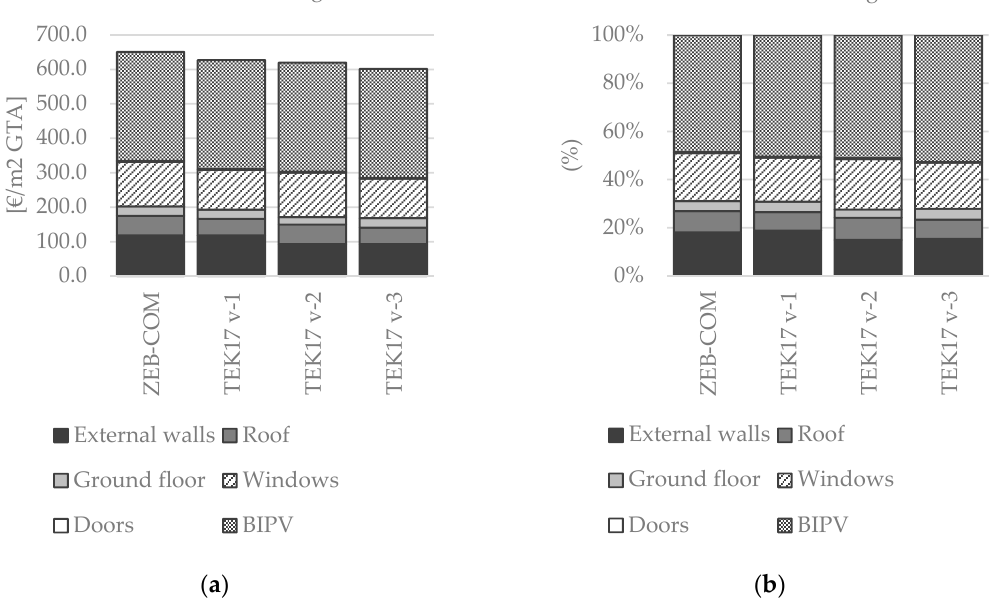
Figure 2. Initial investment costs of the four designs shown in euros ( a ) and as shares of the total ( b